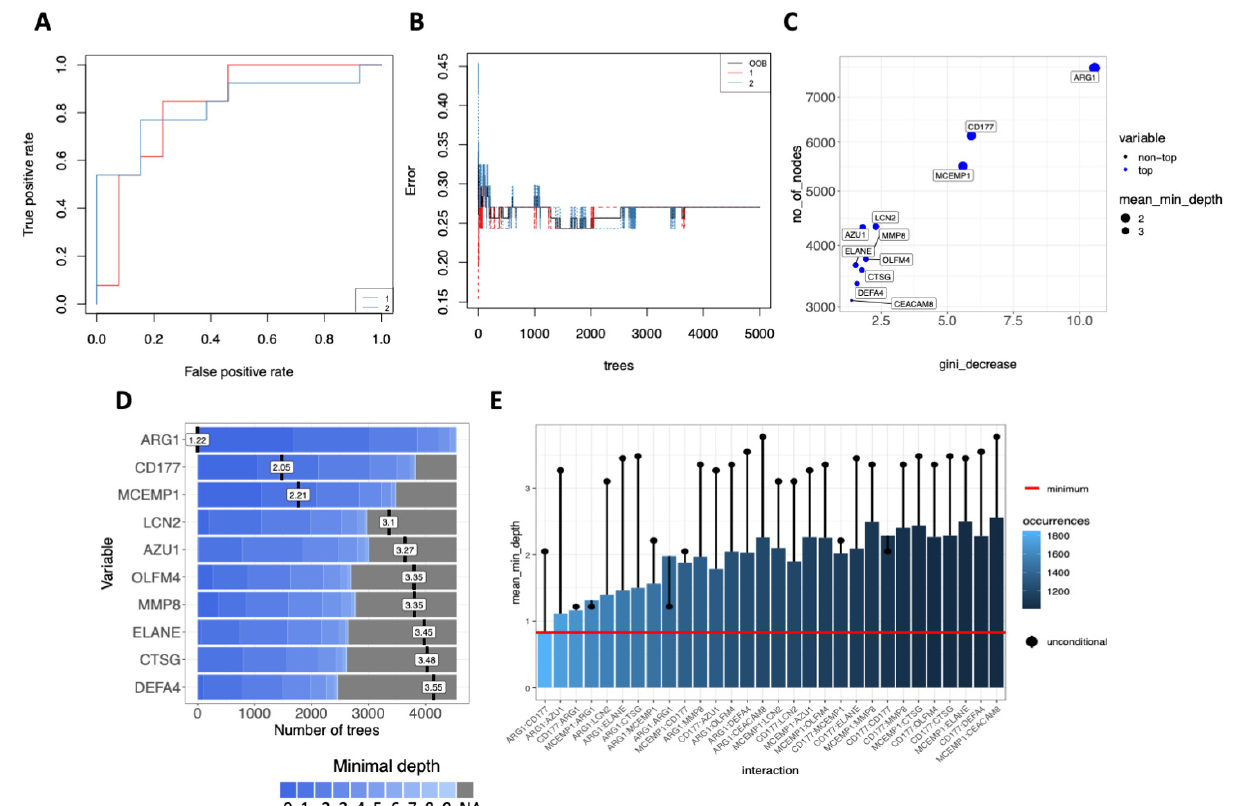
Figure 7. Random Forest prediction analysis suggests potential biomarkers for severe COVID-19. ( A ) Receiver operating characteristics (ROC) curve of 11 genes from COVID-19_ICU compared to COVID-19_nonICU patients with an area under the curve (AUC) of 82.4% for both groups. 1 = COVID-19_nonICU; 2 = COVID-19_ICU. ( B ) Stable curve showing number of trees and error rate (out of bag or OOB) with medium of 27.03%. 1 = COVID-19_nonICU; 2 = COVID-19_ICU. ( C ) Variable importance scores plot based on Gini decrease and number (no) of nodes for each variable showing which variables are more likely to be essential in the random forest’s prediction. ( D ) Ranking of the top 10 variables according to mean minimal depth (vertical bar with the mean value in it) calculated using trees. The blue color gradient reveals the min and max minimal depth for each variable. The range of the x -axis is from zero to the maximum number of trees for the feature. ( E ) Mean minimal depth variable interaction plot showing the most frequent occurring interactions between the variables on the left side with light blue color, and least frequent occurring interactions on the right side of the graph with dark blue color. The red horizontal line indicates the smallest mean minimum depth and the black lollipop represents the unconditional mean minimal depth of a variable.